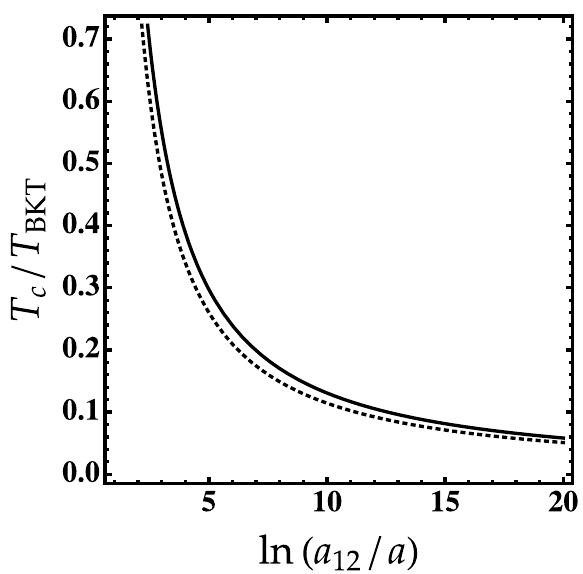
Figure 4. Critical temperature normalized to T BKT as a function of ln ( a 12 / a ) . Solid line: without higher-order effects. Dotted line: higher-order